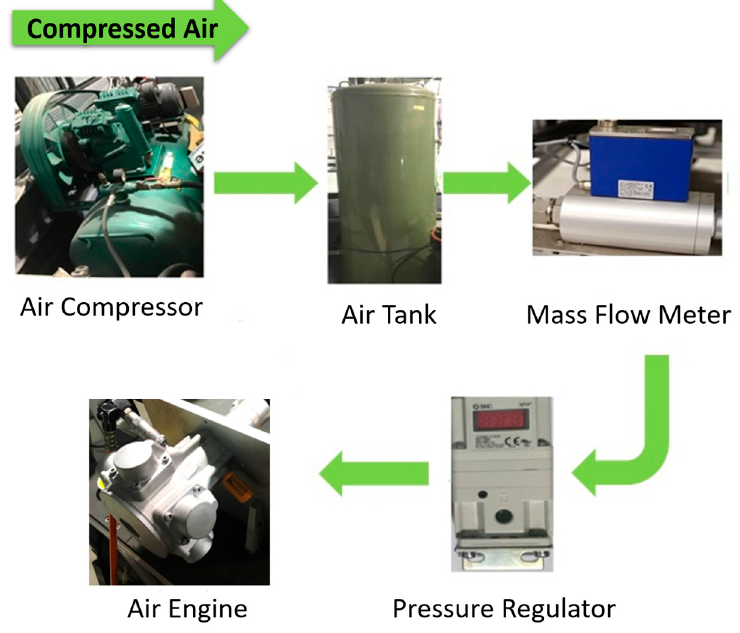
Figure 7. Key components of air engine power system .